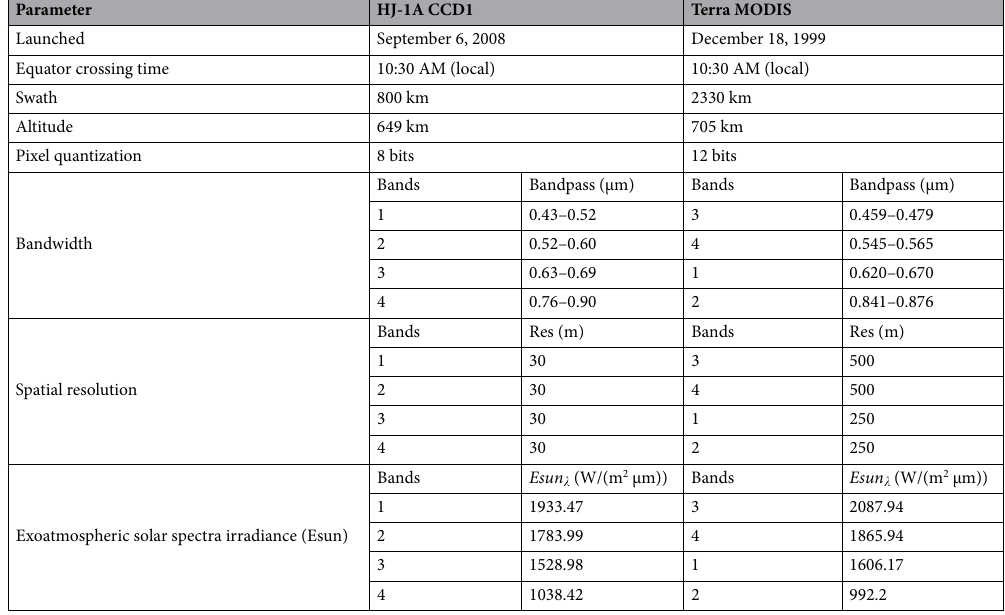
Table 1. Sensor characteristics of HJ-1A CCD1 and MODIS.